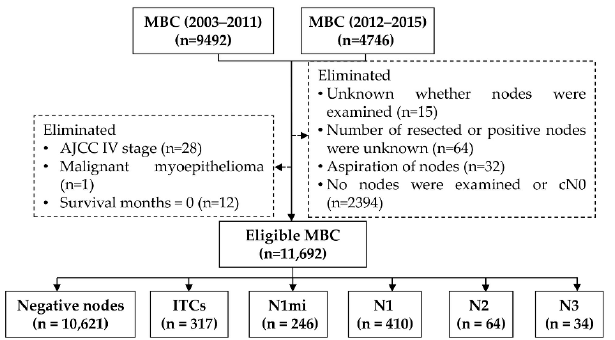
Figure 1. The flow chart of patient inclusion and exclusion. AJCC: American Joint Committee on Cancer, ITCs: isolated tumor cells, MBC: microinvasive breast cancer, N1: 1–3 positive nodes, N2: 4–9 positive nodes, N3: ≥ 10 positive nodes, N1mi: micrometastases nodes.